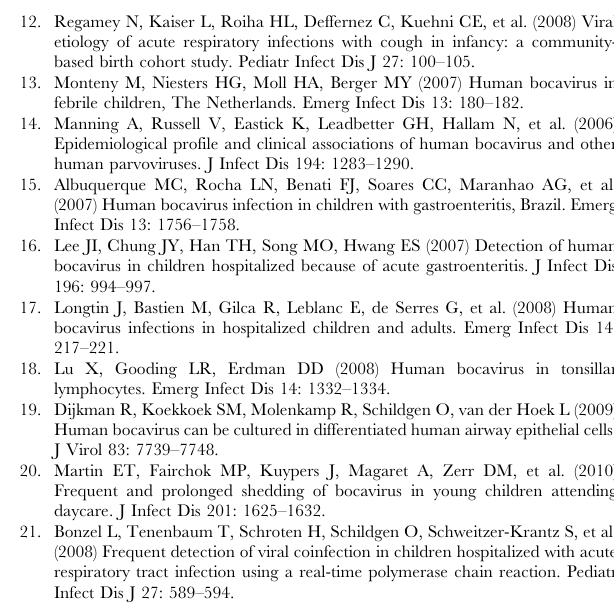
Table S2 Clinical and demographic data of ARI patients Table S3 Frequencies of detection of other respiratory viruses in HBoV positive and negative samples. Table S4 Clinical and demographic data of patients in whom HBoV was detected alone or simultaneously with other respiratory viruses. Table S5 HBoV loads determined by real time PCR